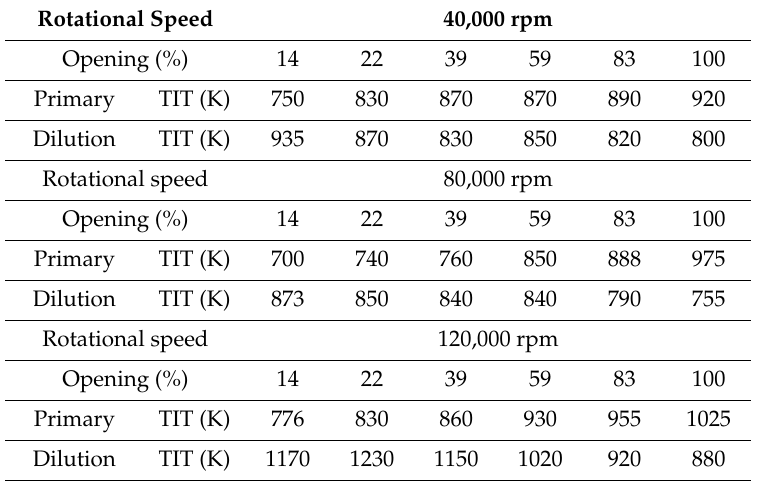
Table 1. Impact of the combustion chamber air holes variable geometry on turbine inlet temperature. Rotational